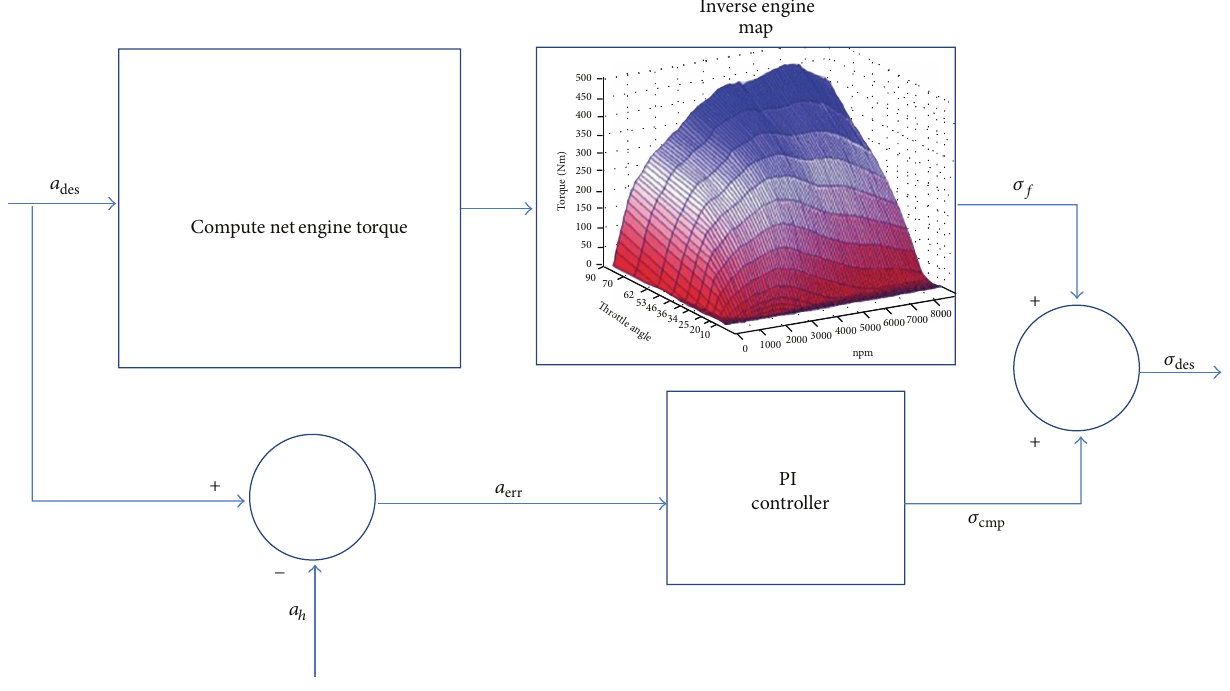
Figure 6: Throttle